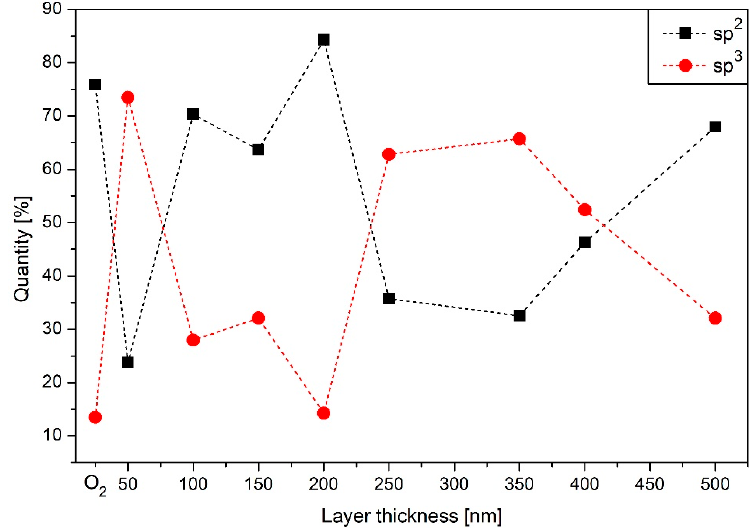
Figure 7. Results for the sp 2 (squares) and sp 3 (circles) from the XPS series for PHB coated with increasingly thick a-C:H layers. The dashed lines are included to enhance visibility.